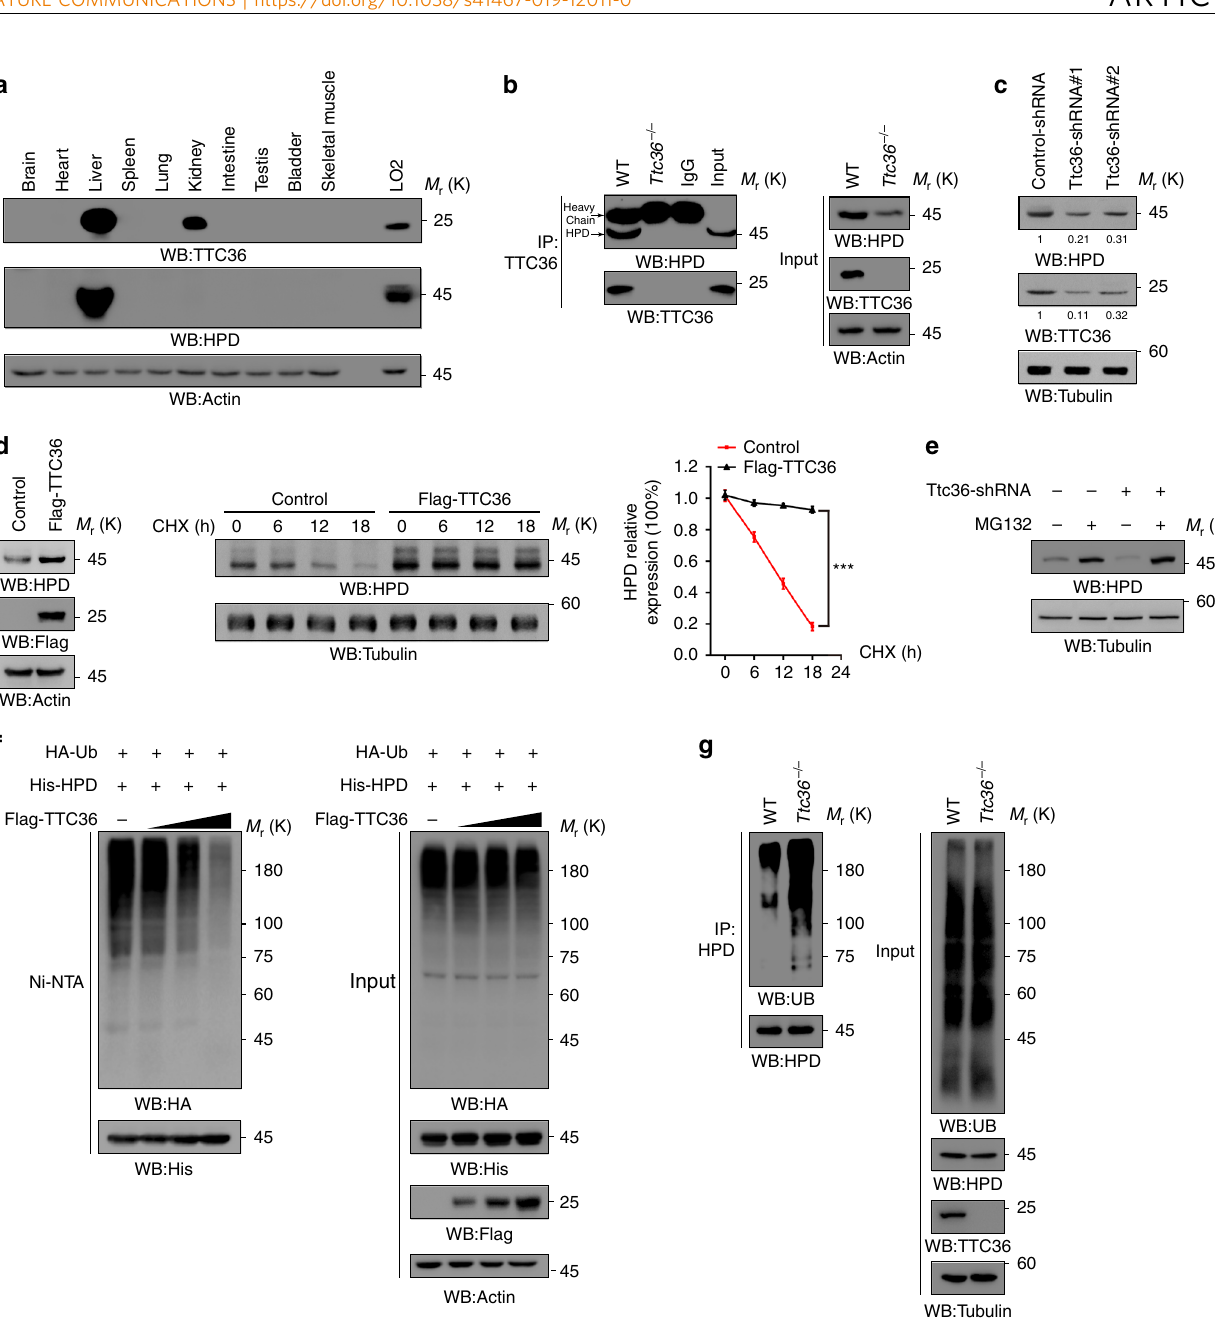
Fig. 1 TTC36 interacts with HPD and blocks HPD polyubiquitylation and degradation. Immunoblotting analyses were performed with the indicated antibodies a – g . a Proteins were extracted from the indicated organs of C57BL/6 mouse. Lysates of LO2 human fetal hepatocytes were used as controls. b Cell lysates were extracted from mouse primary hepatocytes that isolated from the livers of wild type (WT) and Ttc36 − / − C57BL/6 mouse. Immunoprecipitation with an anti-TTC36 antibody were performed. c LO2 cells were stably transfected with a vector expressing a control shRNA or two different Ttc36-shRNAs. The quanti fi cation numbers represent relative intensity of presented bands. d LO2 cells with or without expressing Flag-TTC36 were prepared (left); LO2 cells with or without expressing Flag-TTC36 were treated with 10 μ g mL − 1 cycloheximide (CHX), and the cells were harvested at different time points (middle); quanti fi cation of HPD levels, respectively, relative to 0 h is shown (right). Data represent the means ± s.d. of three independent experiments. *** P < 0.001, based on the Student ’ s t- test. e LO2 cells with or without expressing Ttc36-shRNA#1were treated with or without MG-132 (10 μ M) for 12 h. Immunoblotting analyses were performed with the indicated antibodies. f HEK293T cells were transfected with vectors expressing HA-ubiquitin, His-HPD, and TTC36 (0, 1, 2, or 4 μ g). MG-132 (10 μ M) was added to the cells 12 h before they were harvested with a guanidine – HCl-containing buffer. His-HPD was precipitated by the Ni-NTA beads and immunoblotting analyses were performed with the indicated antibodies. Ub ubiquitin. g Mouse primary hepatocytes of WT or Ttc36 − / − C57BL/6 mouse were treated with MG-132 (10 μ M) for 12 h. The cells were harvested with denature buffer. Immunoprecipitation was performed with an anti-HPD